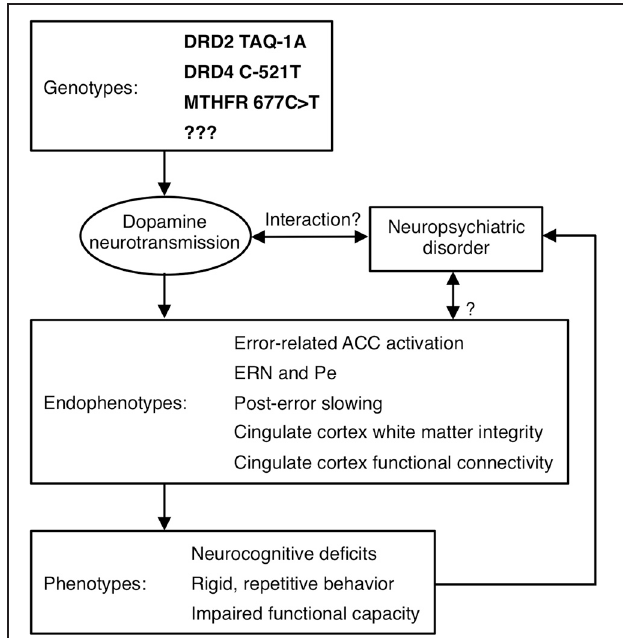
FIGURE 4 | Model of a causal pathway for error processing. Specific genetic polymorphisms affect dopamine neurotransmission, which may interact with a neuropsychiatric disorder to affect neuroimaging-based endophenotypes. These endophenotypes, in turn, contribute to the expression of phenotypes, which may influence whether a psychiatric diagnosis is